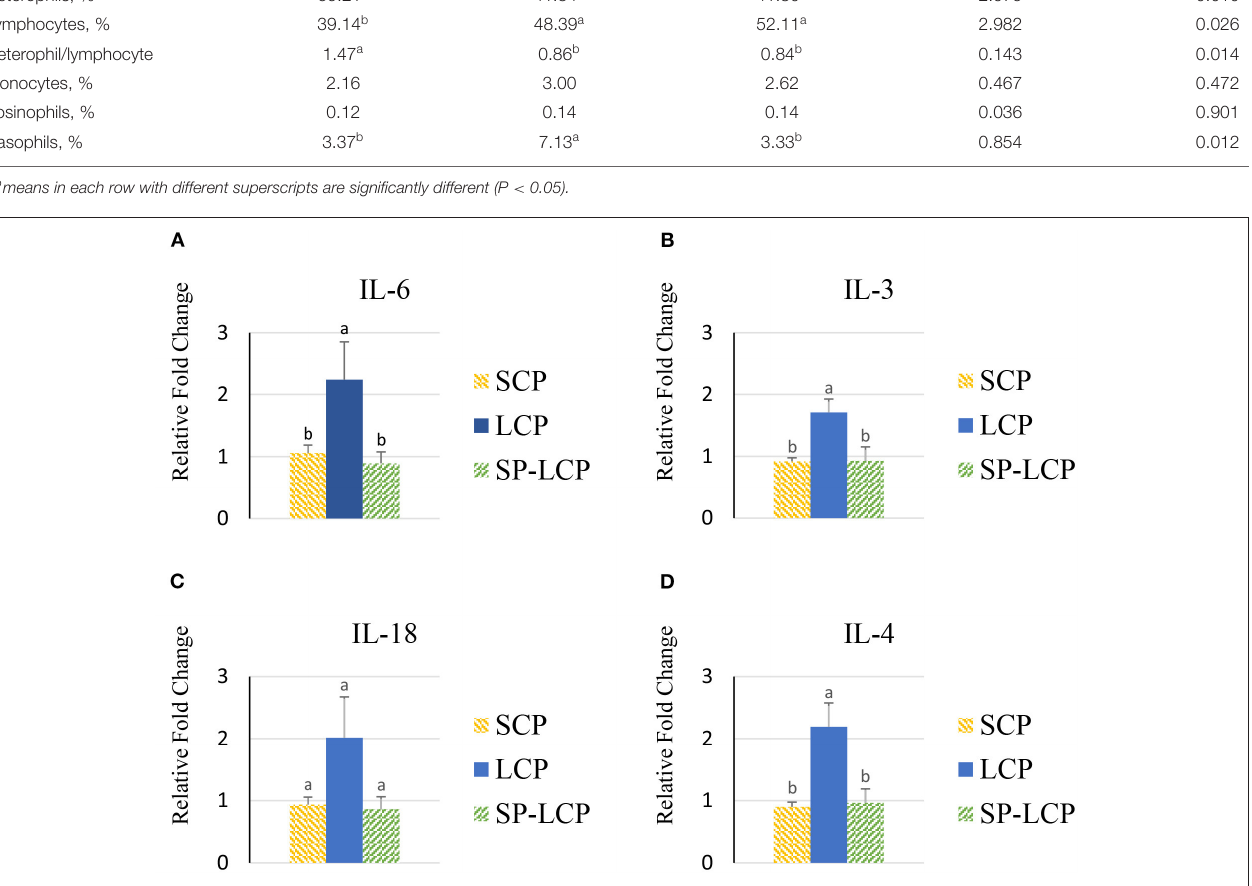
FIGURE 1 | Effects of Spirulina on circulating cytokine expression profile. Relative mRNA abundance of circulating IL-6 (A) , IL-3 (B) , IL-18 (C) , and IL-4 (D) in broilers on day (d) 37 were determined by real-time qPCR. Treatments include standard corn/soy (SCP) diet as control and low crude protein without (LCP) or with Spirulina (SP-LCP). Data are presented as mean ± SEM ( n = 8/group). Means with different letters are significantly different ( P <